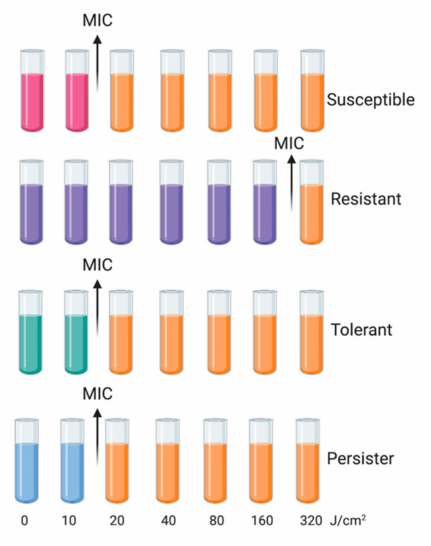
Figure 1. Minimum inhibitory concentration (MIC) characteristics of bacterial responses to light-based treatments. MIC values for bacterial strains resistant to light-based treatment are significantly higher than those for susceptible strains. Resistance is an acquired and inherited decline in the effectiveness of a given treatment (the need for higher concentrations of a photosensitizing agent); Tolerance is an acquired stable feature (the need for longer treatment duration to achieve the same killing efficacy regardless of the concentration of the photosensitizing agent); Persistence is a nonheritable and dormant phenotypic state (transient tolerance) represented by a small subpopulation (about 0.1–1%). Colored probes represent bacterial growth, and orange indicates growth inhibition due to phototreatment conditions leading to cell death. MIC values for strains expressing tolerance or persistence are similar to those of susceptible strains. Concentrations are chosen for illustration purposes only (modified from Brauner et